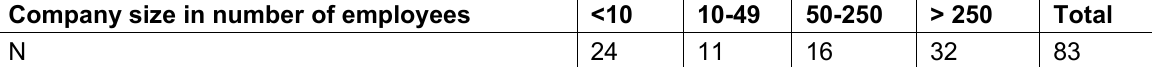
Table S1 : Company size in number of employees. Company size in number of employees N